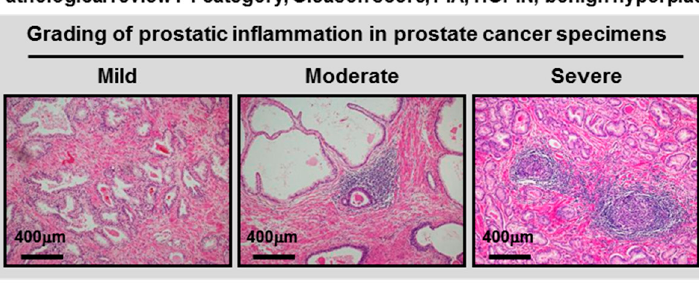
Figure 1. Flow chart of the study design. Intraprostatic inflammation was graded based on the typical inflammatory cell density into three categories: mild, moderate, and severe [11,12]. Abbreviations: PCa: prostate cancer, RALP: robot-assisted laparoscopic radical prostatectomy, BPH: benign prostate hyperplasia, TURP: transurethral resection of the prostate, PCR: polymerase chain reaction, HPV: human papillomavirus, PIA: proliferative inflammatory atrophy, and HGPIN: high-grade prostatic intraepithelial neoplasia.